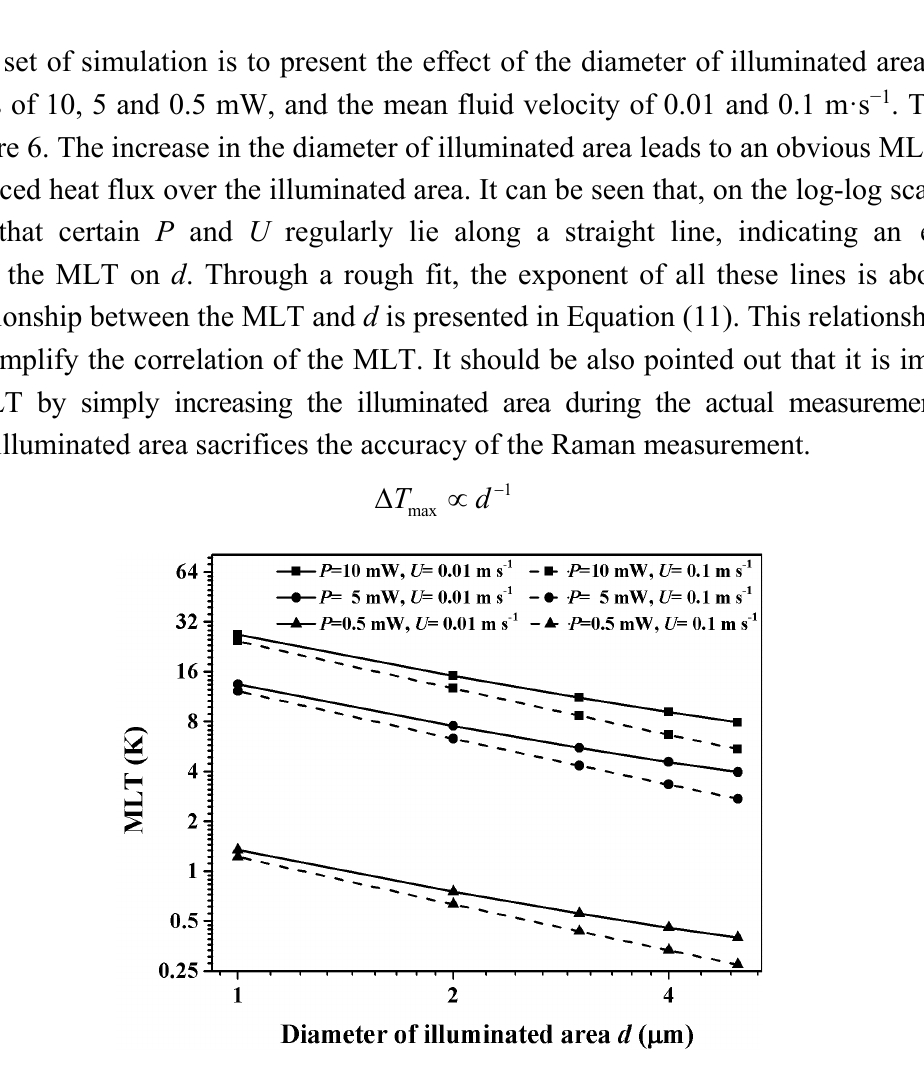
Figure 6. Effect of the diameter of illuminated area at the mean velocity of 0.01 m·s − 1 (solid line) and 0.1 m·s − 1 (dashed line) when the surface powers are 10 mW ( ■ ), 5 mW ( ● ) and 0.5 mW ( ▲ ), respectively. The microchannel is 800 μ m wide, 30 μ m high and 10 mm long. The chip is 10 mm wide, 0.4 mm thick and 10 mm